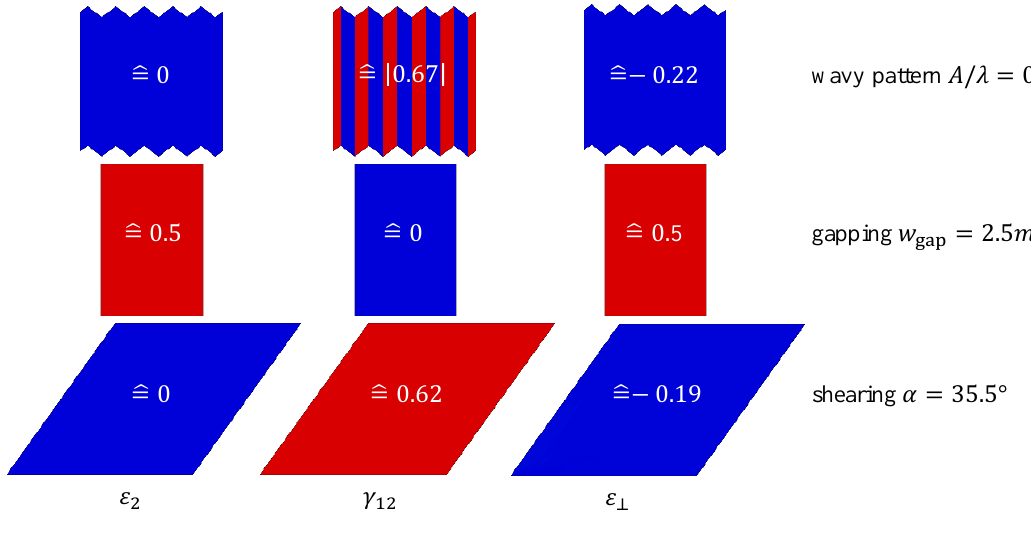
Figure 9. Strain components for selected load cases for each draping